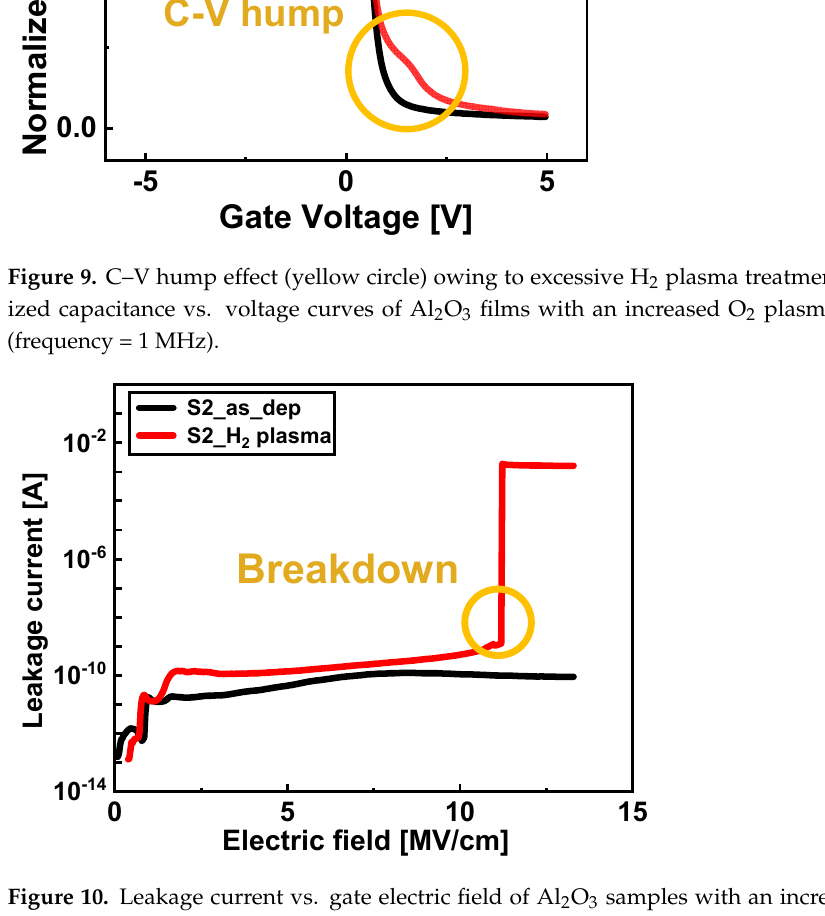
Figure 10. Leakage current vs. gate electric field of Al 2 O 3 samples with an increased O 2 plasma exposure time.